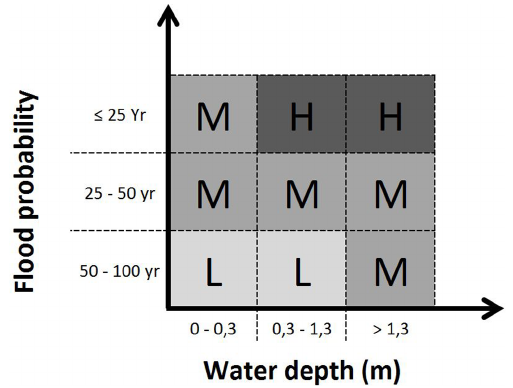
Fig. 4. Levels of hazard used for the official flood hazard maps of the Walloon region. They are defined based on a combination of the water depth (horizontal axis) and the range of return period (vertical axis). H represents high flood hazard; M, medium flood hazard; L, low flood hazard. Adapted from Groupe Transversal Inondations